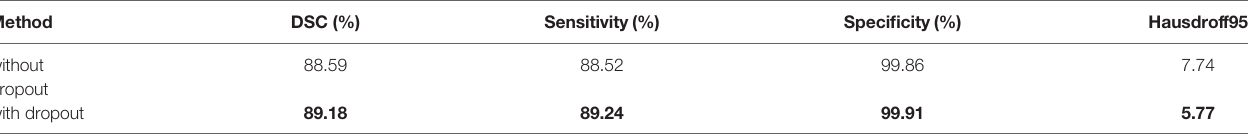
The bold values indicate the best